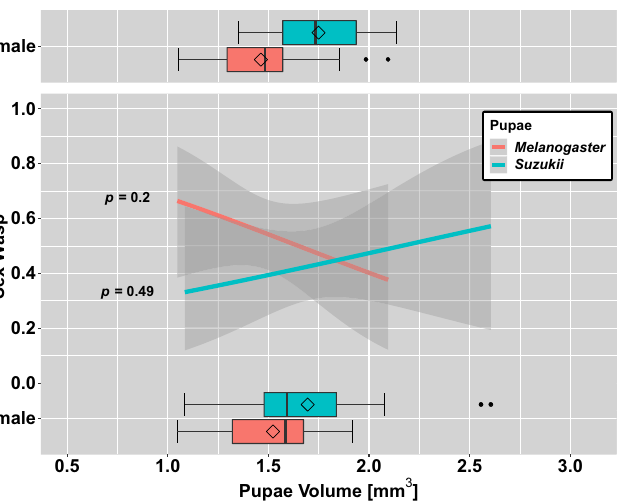
Figure 7. Sex of emerged T. drosophilae from a choice test situation depending on the host pupal volume of D melanogaster (red) and D. suzukii (blue). Boxplots give the variation in size for the pupae from which male and female wasps emerged. Curves are estimated proportions of the sex as a function of pupal volume with a 95% confidence interval (binomial GLMM, Table